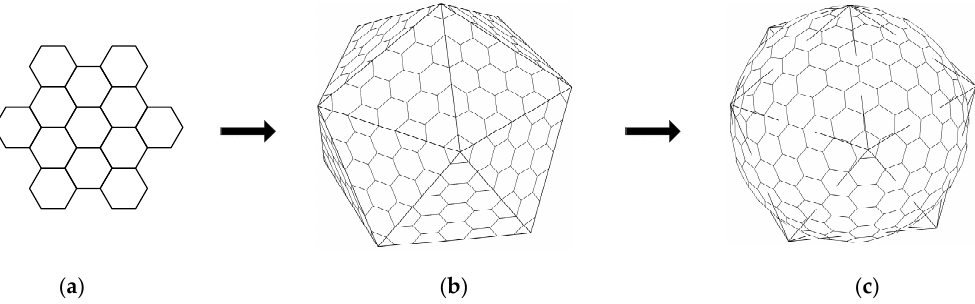
Figure 2. The general idea of using the icosahedron to construct the hexagonal DGGS: ( a ) the planar hexagonal grid system; ( b ) the icosahedral hexagonal grid system; ( c ) the hexagonal DGGS obtained by projecting the (b) (source—own study).